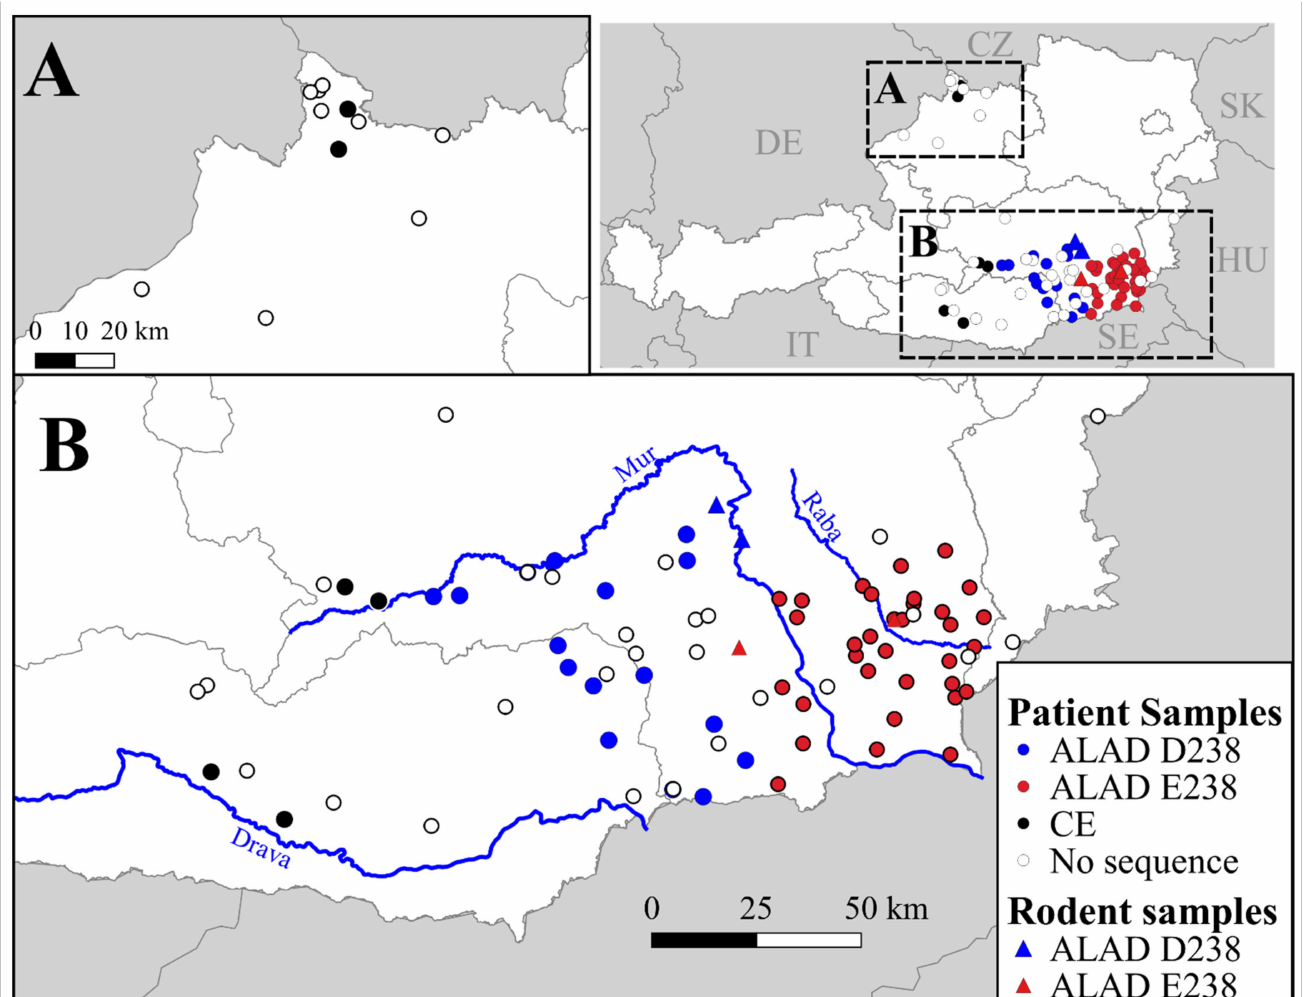
Figure 2. Maps of Austria showing approximate locations of Puumala orthohantavirus (PUUV) sequences. In the upper right panel, Austria is shown in white with grey borders around Federal States, and surrounding countries are coloured grey with white country borders labelled with two-letter country codes (CZ = Czech Republic, DE = Germany, HU = Hungary, IT = Italy, SE = Slovenia, SK = Slovakia). The two regions outlined in dashed squares are shown on a larger scale in panels A : a region in north central Austria, and B : a large cluster in South-eastern Austria. Human patient samples are shown as coloured dots according to genotype: two Alpe-Adria (ALAD) genotypes are shown in red or blue with respect to a nonsynonymous substitution in the nucleocapsid protein at site 238 (D238, blue; E238, red); locations of Central European (CE) genotypes are shown in black. Sample locations from which no sequence was obtained are shown as white dots. Origins of five sequenced rodent samples ( Clethrionomys glareolus ) are shown as triangles coloured as described above, with the easternmost pair